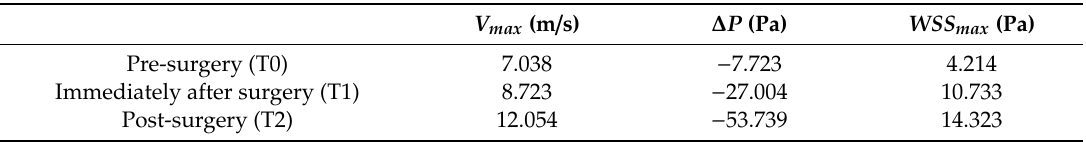
Figure 5. 3D distribution of WSS (wall shear stress) for pre-surgery, immediately after surgery, and post-surgery. Table 2. Flow parameters in this study. Maximum velocity ( V max ), pressure drop ( ∆ P ), and maximum wall shear stress ( WSS max ).